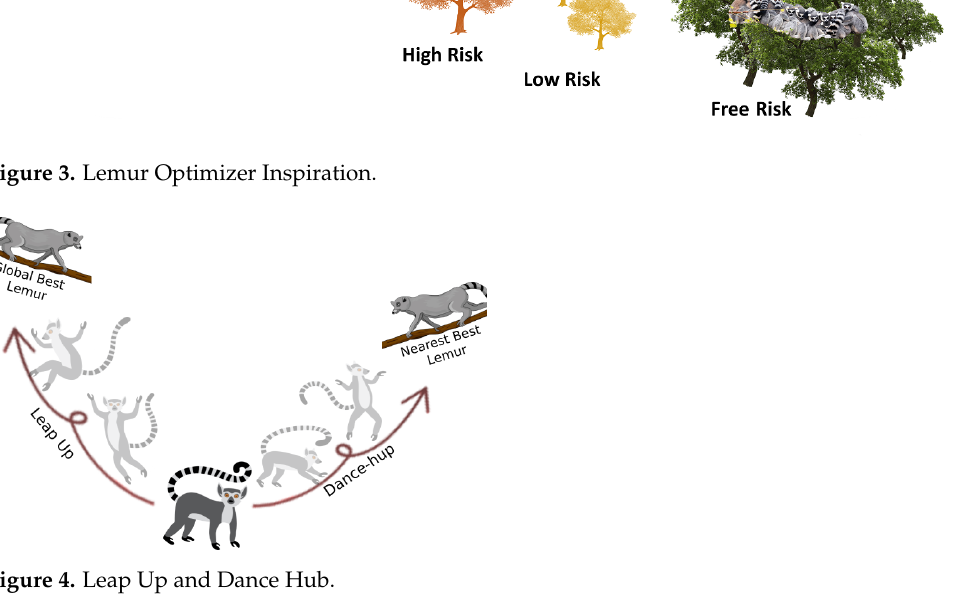
Figure 4. Leap Up and Dance